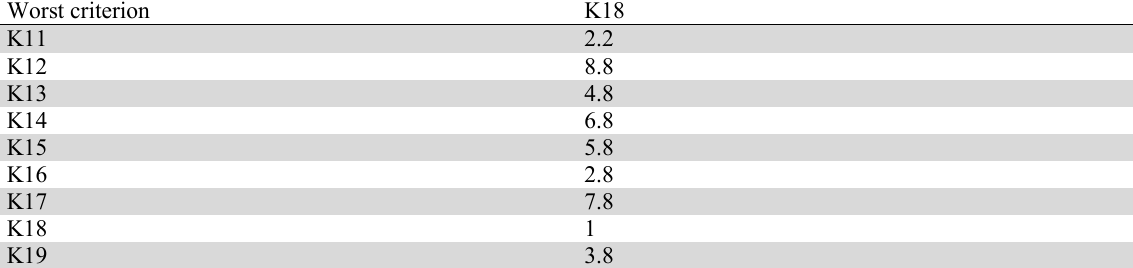
Actors and Networks sub-criteria OW Vector Worst